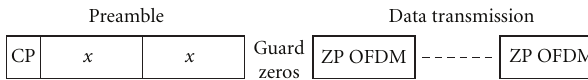
Figure 2: The data burst structure considered in this paper, which consists of a special CP-OFDM preamble and multiple ZP-OFDM